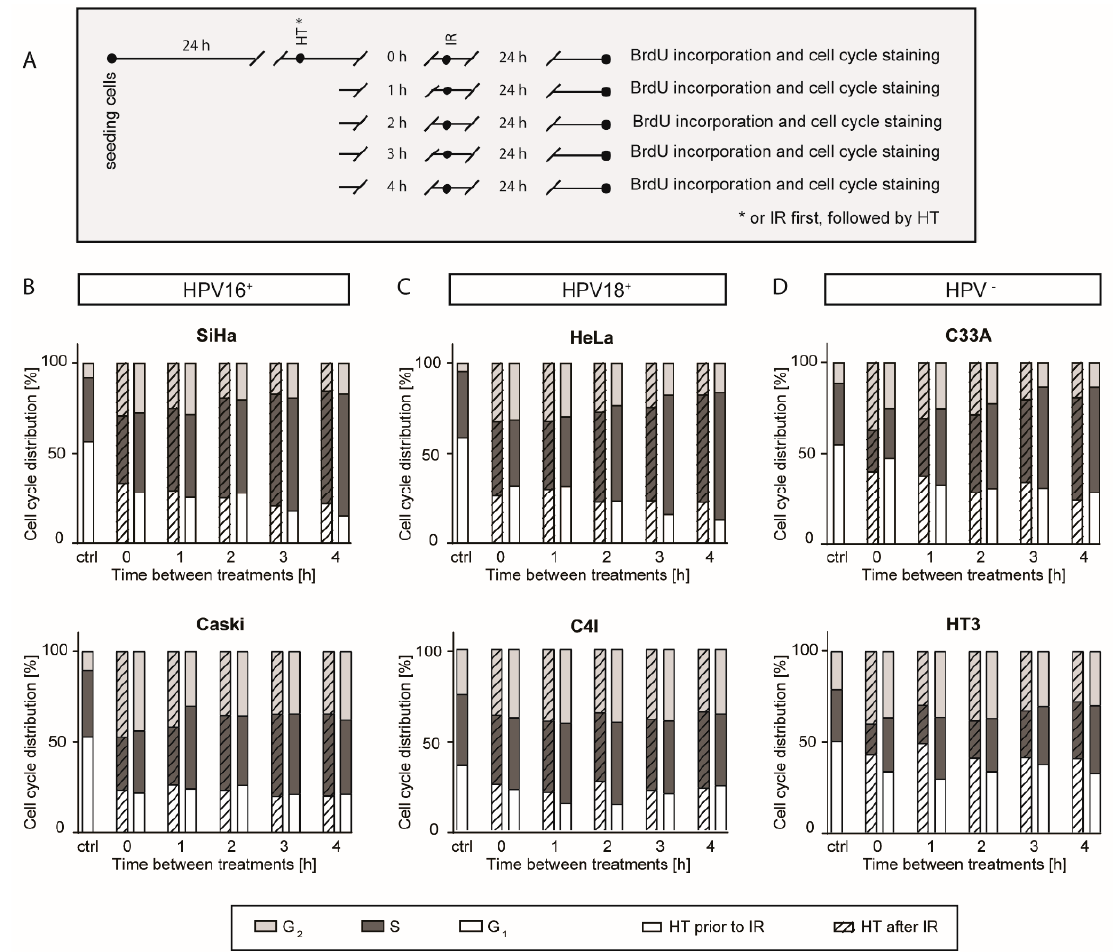
Figure 2. More pronounced G2 arrest after a short time interval between ionizing radiation and hyperthermia. Cell cycle distribution, using BrdU incorporation after different time intervals and sequences of ionizing radiation (IR) and hyperthermia (HT), was performed on six cervical cancer cell lines. ( A ) Schematic overview of treatment. ( B–D ) Cell cycle distribution of the cell lines, from left to right: HPV 16 + cell lines SiHa and Caski, HPV18 + cell lines HeLa and C4I, and HPV-negative cell lines C33A and HT3. Untreated samples are marked as control (ctrl). In the samples treated with a short time interval (0 h) between the two therapies, a more pronounced increase in G2 phase was observed and in some cell lines after a time interval (4 h) between the two therapies, the S phase was increased. However, cell cycle distribution was more dependent on the cell line than on the type of HPV. Means of at least four replicates are